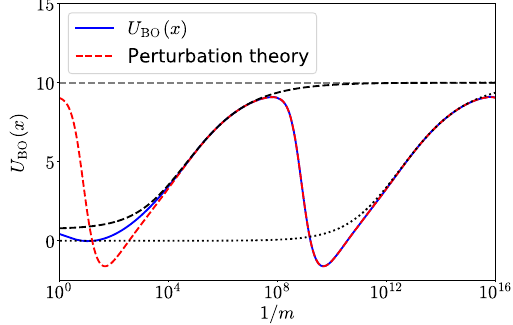
x Þ evaluated at FIG. 8. Born-Oppenheimer potential U FIG. 7. Ground-state energy E 0 of H in Eq. (25) for a fixed BO ð fast x ¼ 10 as a function of 1 =m (blue). The red dashed line showing value x ¼ 0 as a function of 1 =m (blue). For certain regimes of m , the result of the second-order perturbation theory in x is periodic E 0 is well approximated by the ground-state energy correspond- in log ð 1 =m Þ ; see main text. For nonlinear inductors of type 2, ing to a purely quartic potential (indicated with black lines). On 10 Þ approaches the value of 10 in the limit of m → 0 (gray U large scales of m , however, E 0 follows the global trend of the BO ð dashed line). For comparison, black lines show the Born- ground-state energy corresponding to a purely quadratic Oppenheimer potential at x ¼ 10 with a nonlinear inductor that potential (red). is described by a purely quartic potential (dashed, y 4 = 10 4 ; dotted, y 4 = 10 8